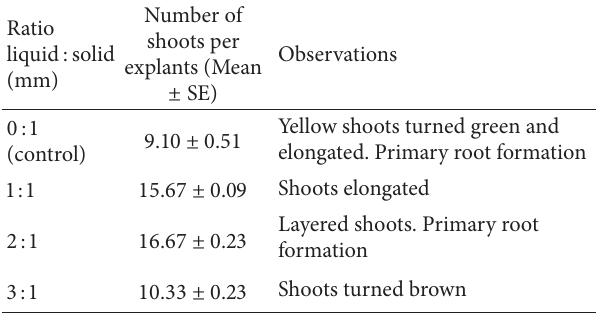
Table 1: The effect of double-layered media on the regeneration of shoots. Cultures were maintained at 25 ± 1 ∘ C with 16 hours of light and 8 hours of dark, with 1000 lux intensity of light for 4